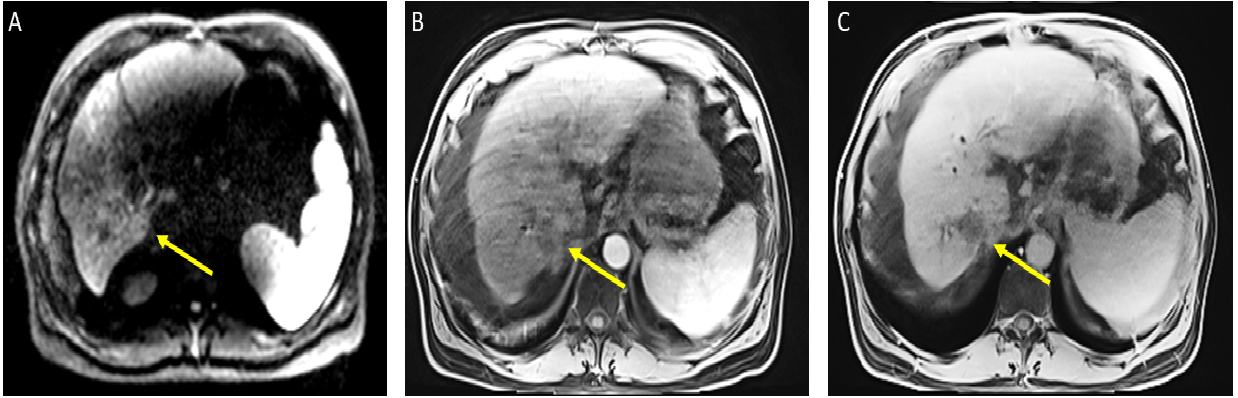
Figure 2. Magnetic resonance imaging of the abdomen. Cirrhosis, splenomegaly, and ascites were noted. Significant interval treatment response. Segment 7 mass has decreased in size (now 3.3 × 3 cm). ( A ) Diffusion-weighted imaging (DWI): decreased diffusion restriction of seg 7 mass; ( B ) (arte- rial)/( C ) (delayed) T1 post-contrast imaging: mass is now hypovascular (captured at the follow-up visit, and 8 weeks after the atezolizumab plus bevacizumab